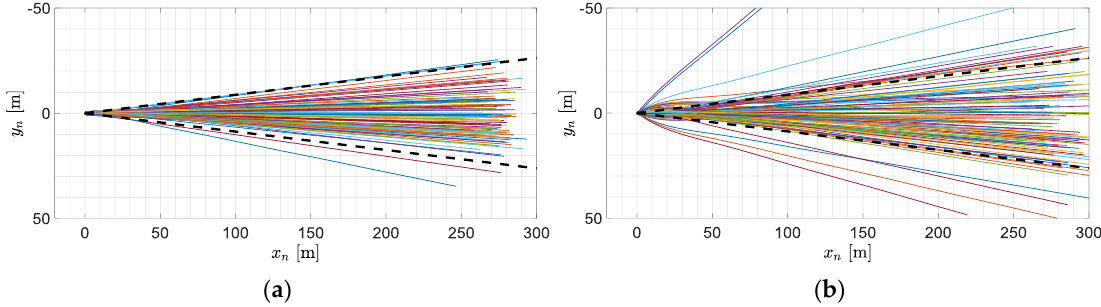
Figure 9. Projectile trajectories projections on O n x n y n for various initial roll rate standard deviations. ( a ) 10°/s; ( b ) 60°/s.